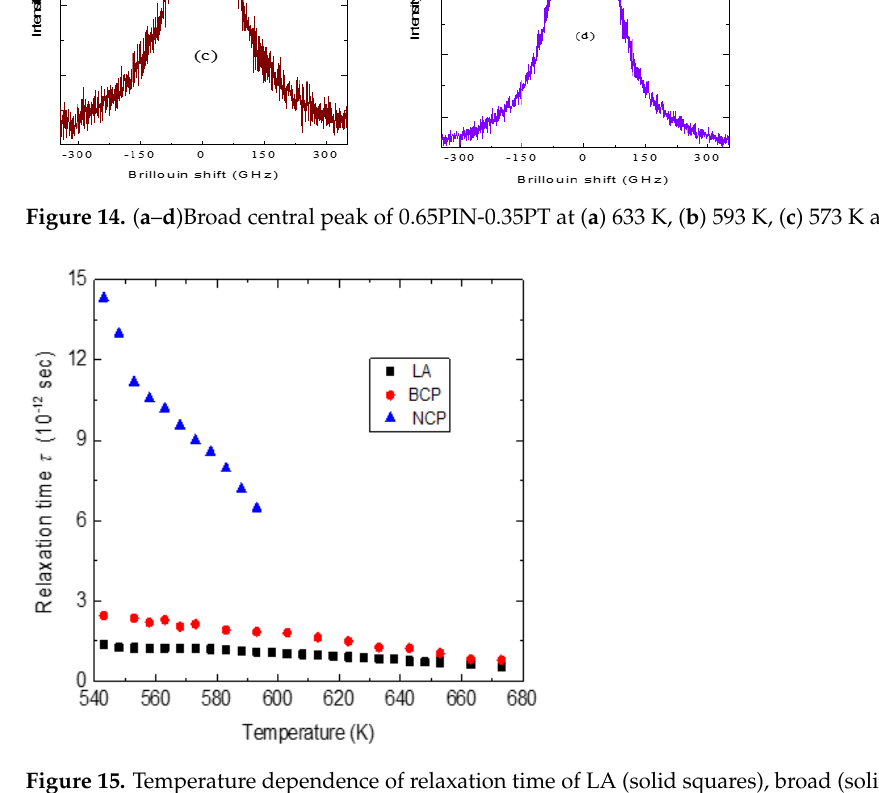
Figure 15. Temperature dependence of relaxation time of LA (solid squares), broad (solid circles) and narrow (solid triangles) central peaks of 0.65PIN-0.35PT.